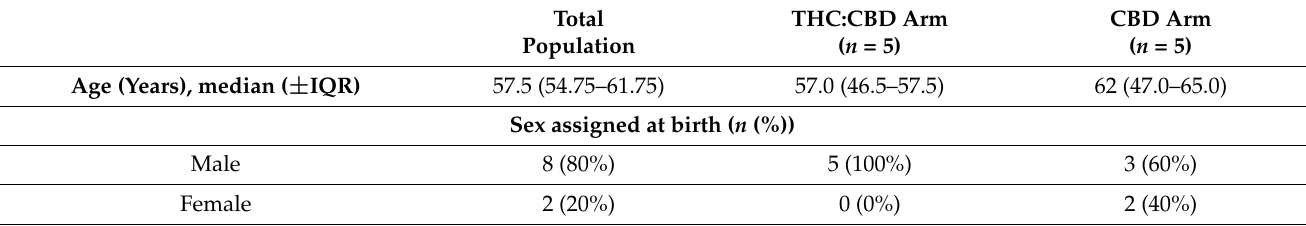
Table 2. Demographic and biological characteristics of study participants at inclusion ( n =